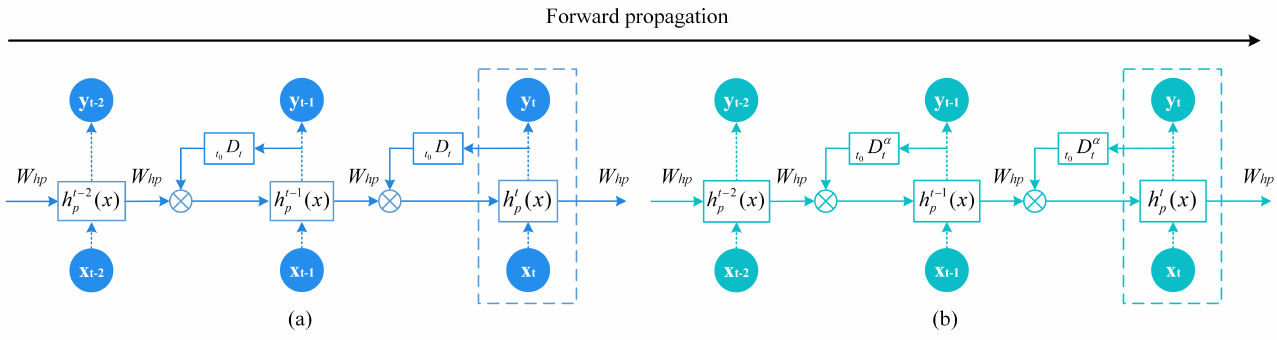
Figure 3. Fractional-order state feedback in the forward propagation of recurrent neural network, ( a ) integer-order state feedback, and ( b ) fractional-order state